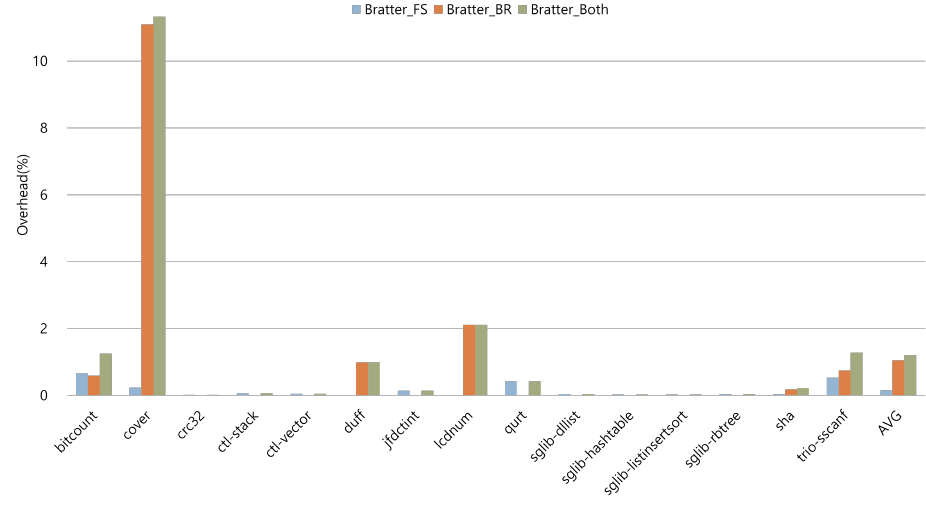
Figure 8. Code size overhead of Bratter